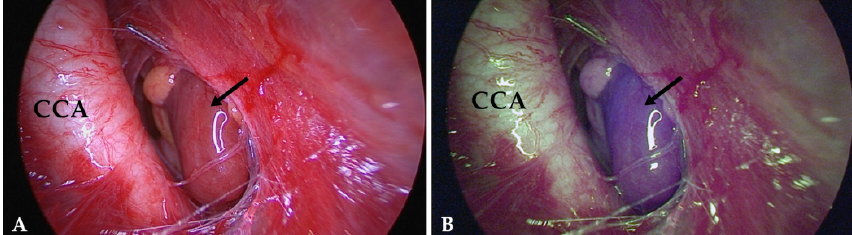
Figure 2. Image of a parathyroid adenoma (arrow) hidden in the vascular sheath close to the common carotid artery (CCA): ( A ) exposed to white light, ( B ) exposed to NIR light. Much like normal parathyroid glands, adenomas display a well recognizable bluish violet color. AF does not allow to distinguish between these two entities.